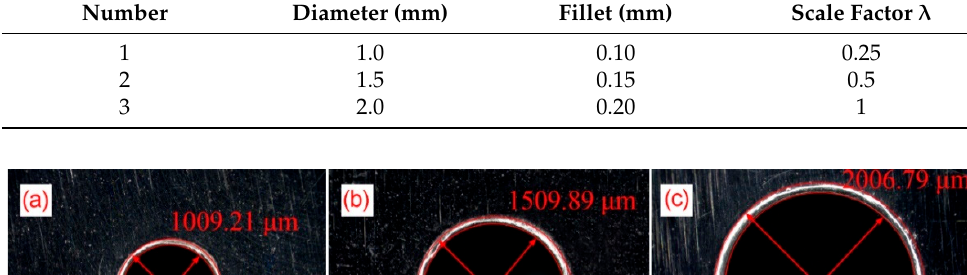
Table 2. Design size of bulging molds.